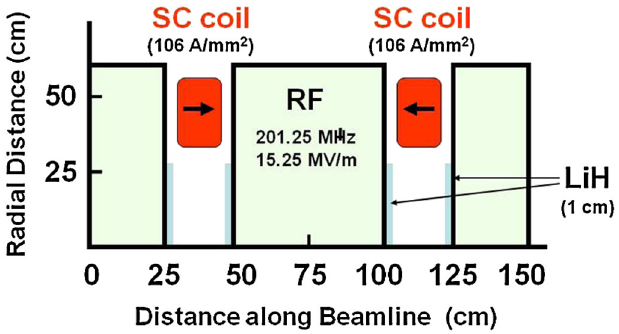
FIG. 5. (Color) Radial cross section of a cooling cell. Note, this design was used in neutrino factory study 2B [9]. The cooling cell includes two rf cavities, four LiH absorbers, and two super- conducting coils providing ASOL